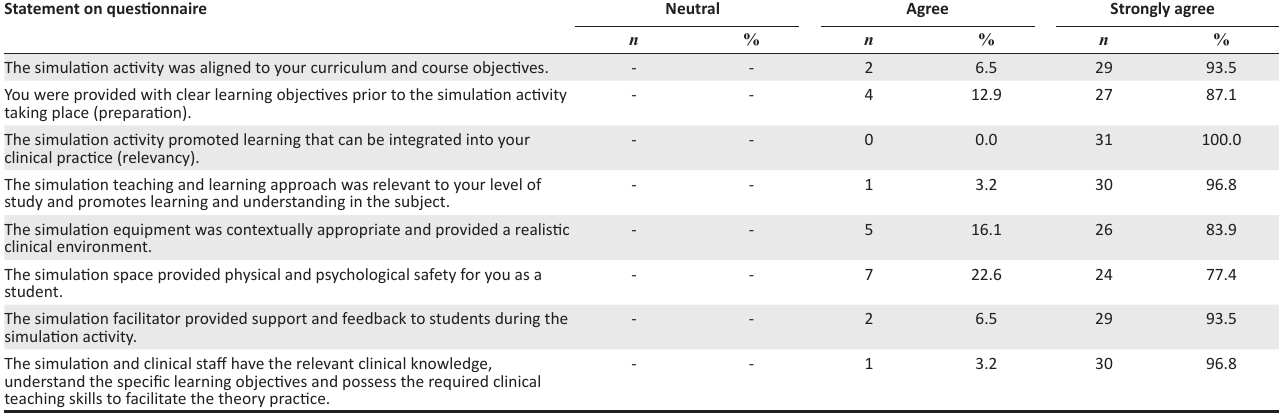
TABLE 1: Students’ feedback as per the Simulation Laboratory Questionnaire ( n = 31). Statement on